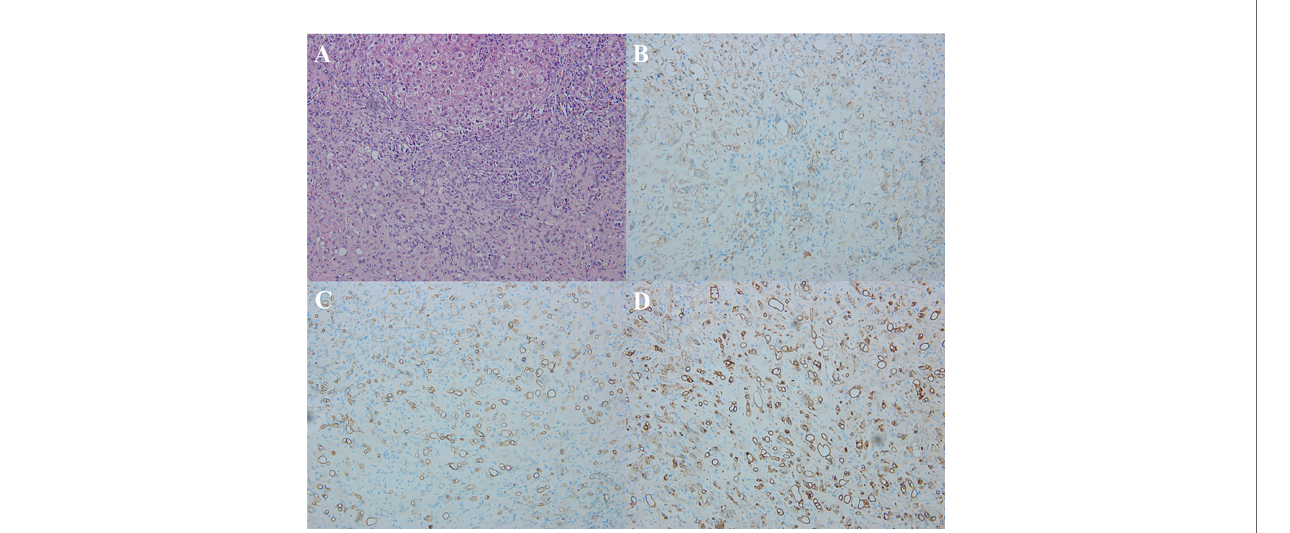
FIGURE 7 | Pathological features of HEHE. (A) Microscopy showed the signet ring-like appearance in the tumor epithelioid cells with intracytoplasmic lumina, containing small amount of red blood cells (H&E staining, × 200). (B) Immunohistochemical staining revealed positive CD31 in the tumor (×200). (C) Immunohistochemical staining revealed positive CD34 in the tumor ( × 200). (D) Immunohistochemical staining revealed positive FVIII Ag in the tumor